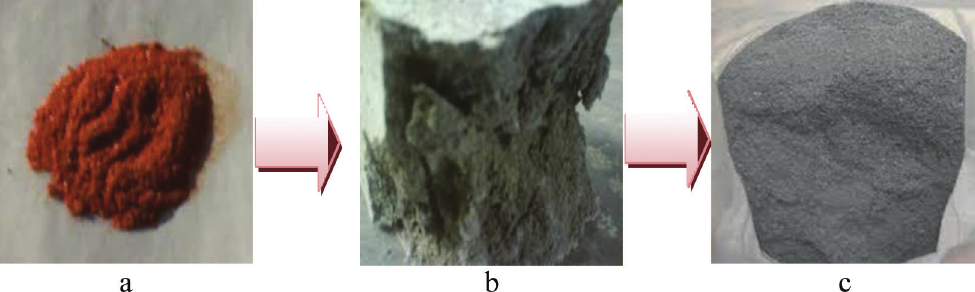
, (b) PdNPs in colloidal form, (c) PdNPs in powder Figure 2: (a) PdCl 2